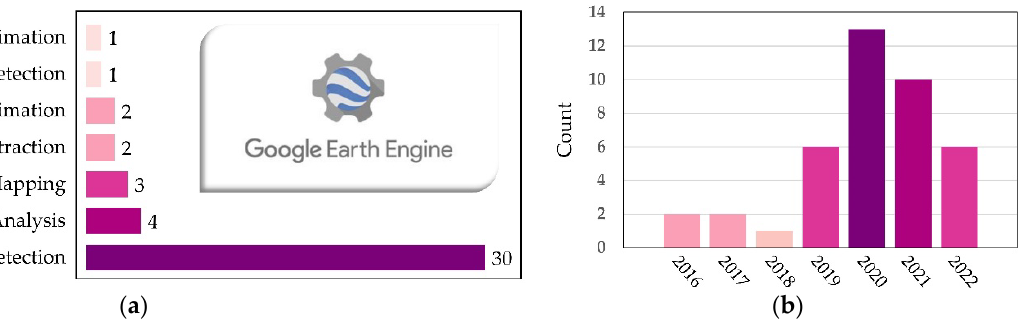
Figure 17. ( a ) Frequency of each type of wetland study using GEE. ( b ) Frequency of GEE-based wetland studies per year.+. Table 7. List of included papers in the meta-analysis that applied GEE in wetland studies sorted by